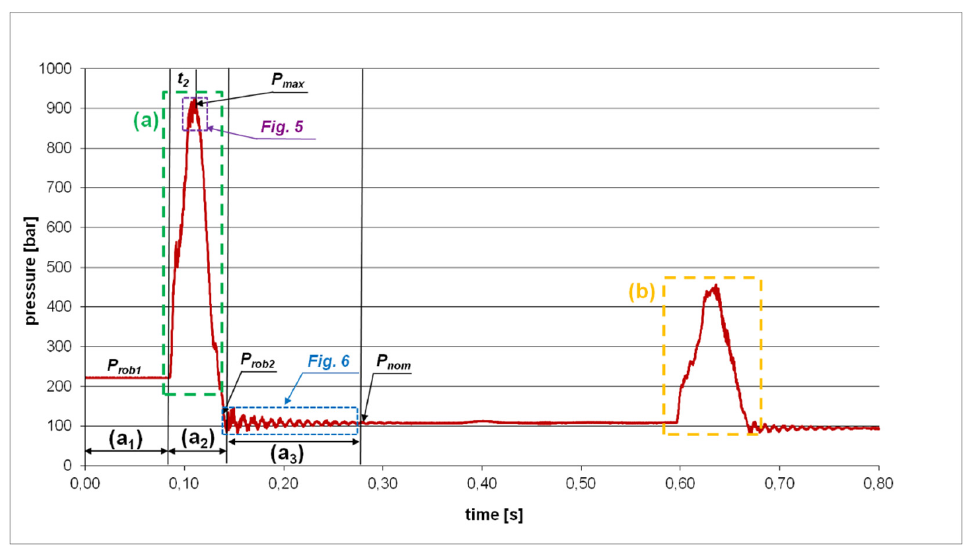
Figure 6. The course of the increase in fluid pressure for power in a specified time in the sub-piston space of a leg when it is loaded with a mass impact.